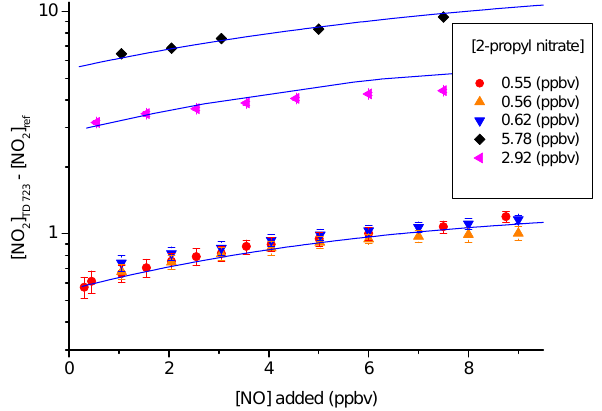
Figure 12. Measurements of the difference signal (TD cavity sam- pling from the 723K inlet – NO 2 reference cavity) when adding dif- ferent amounts of NO 2 to 2-propyl nitrate samples (0.55, 0.56, 0.62, 2.92 or 5.78ppbv). The sample with 0.62ppbv 2-propylnitrate also contained ∼ 5ppbv of NO 2 . The error bars represent standard devi- ation and were derived by propagating errors in the NO 2 signals in the TD and reference cavities. The blue lines show the model pre- dictions of the effect of adding NO to the 723K inlet as described in the text.